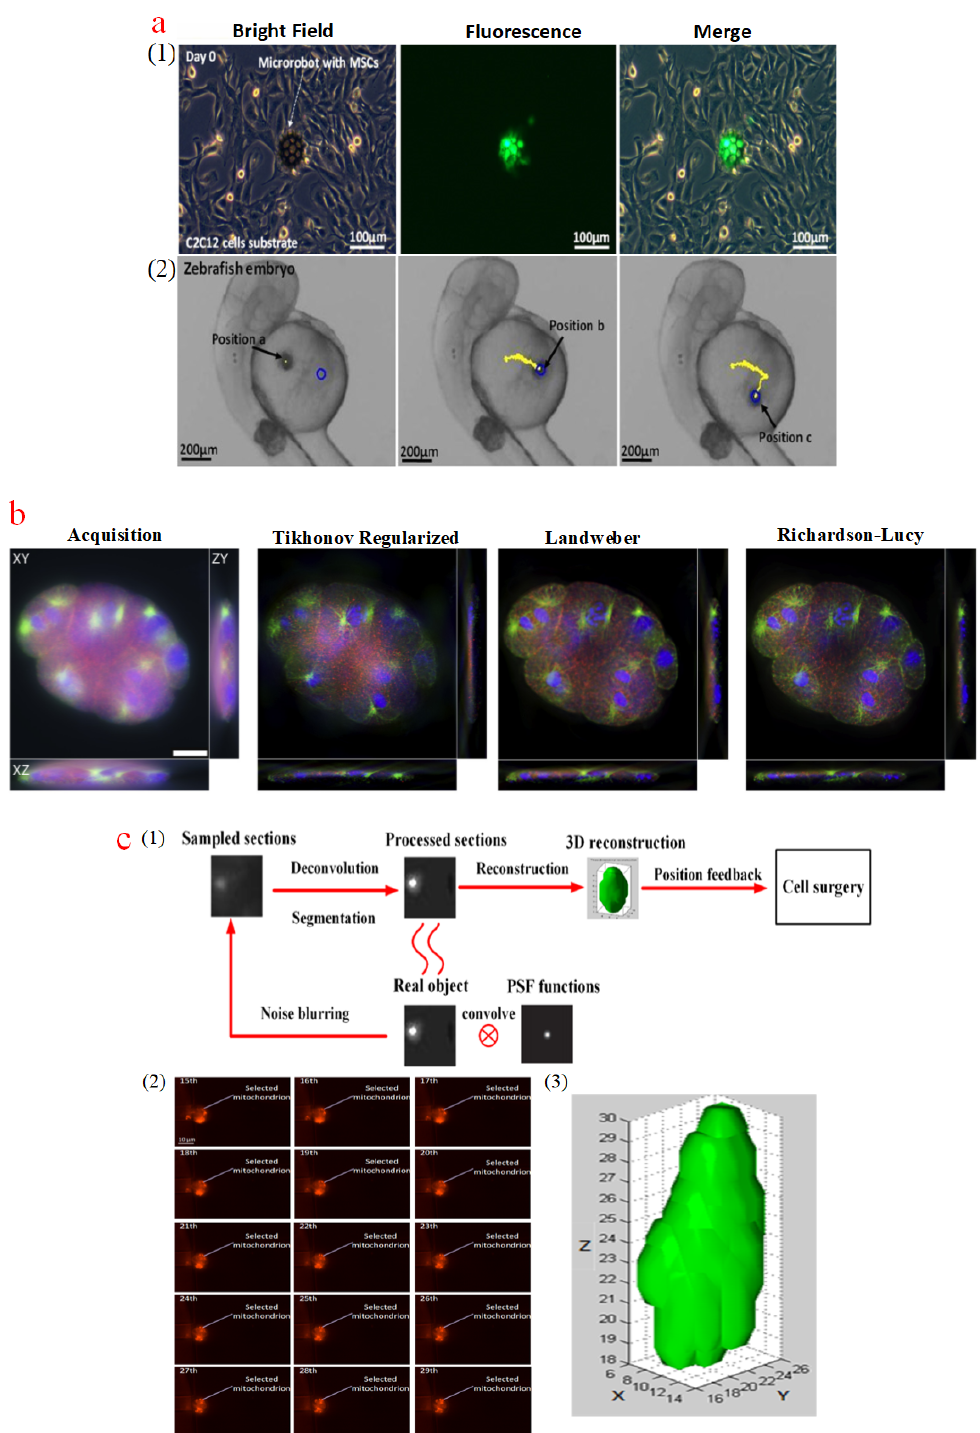
Figure 3. Intracellular imaging practices with WFFM. ( a ) WFFM observations of a burr-like porous spherical microrobot. (1) A microrobot loaded with MC3T3-E1 fibroblasts. (2) The microrobot moving inside the yolk of a zebrafish embryo. Adapted with permission from Reference [97]; ( b ) Blurred sampled image of Caenorhabditis elegans and restored images with different deconvolution methods. Adapted with permission from Reference [106]; ( c ) 3D reconstruction method based on a WFFM. (1) The reconstruction process. (2) The fluorescence image series of the selected mitochondrion (orange). (3) The reconstructed 3D model of the mitochondrion. Adapted with permission from Reference